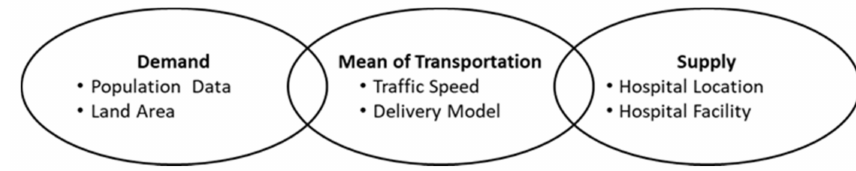
Figure 2. The correlation of input data in GIS.